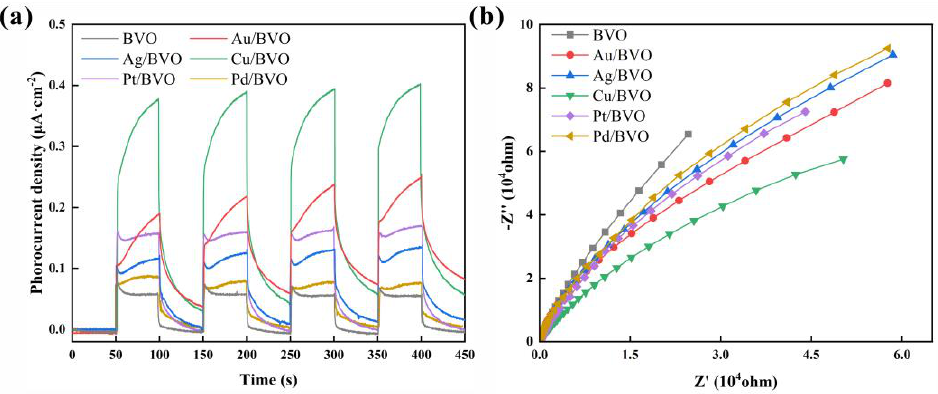
Figure 9. ( a ) Transient photocurrent responses and ( b ) Nyquist impedance plots of all samples.